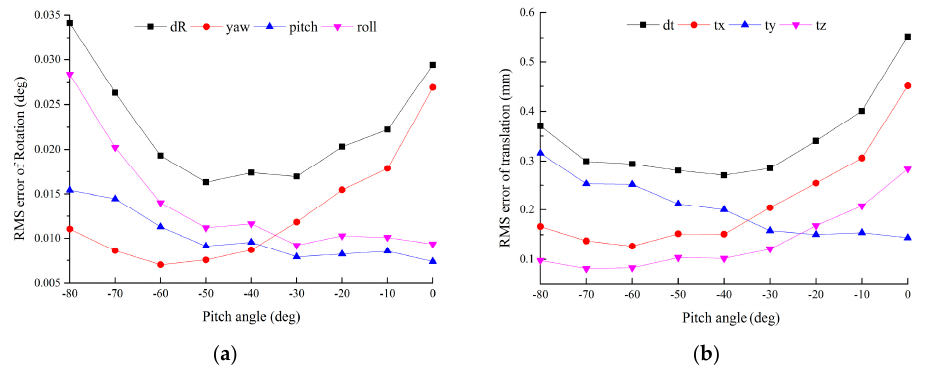
Figure 3. Error vs. the pitch angle of camera relative to the target plane: ( a ) RMS error of rotation vs. the pitch angle; ( b ) RMS error of translation vs. the pitch angle. the pitch angle; ( b ) RMS error of translation vs. the pitch angle.